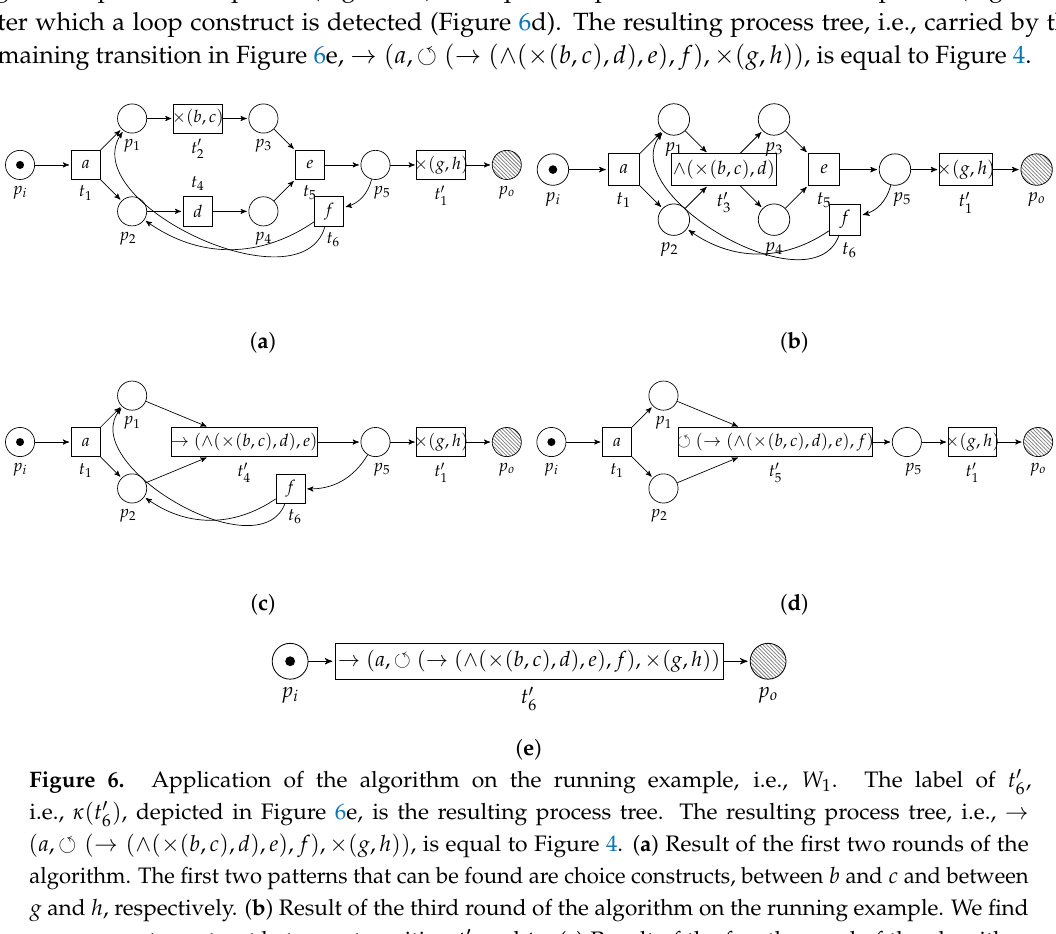
Figure 6. Application of the algorithm on the running example, i.e., W 1 . The label of t (cid:48)